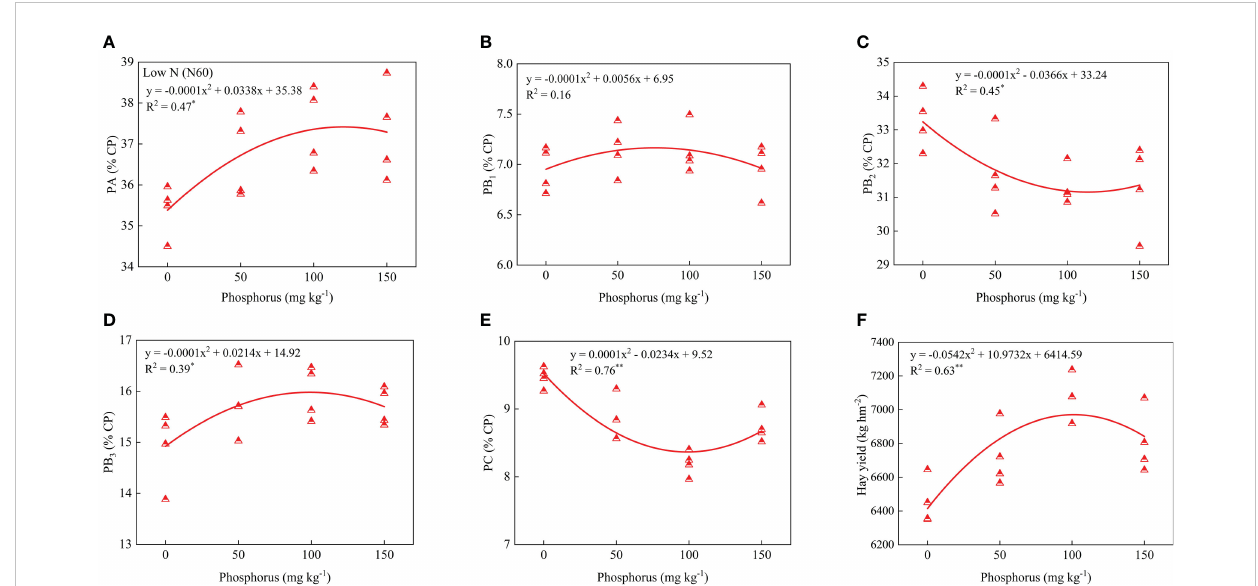
FIGURE 5 Relationship of PA (A) , PB 1 (B) , PB 2 (C) , PB 3 (D) , PC (E) , and forage yield (F) with phosphorus treatments under low nitrogen condition. * and ** indicates the signi fi cant level at p ≤ 0.05 and p ≤ 0.01, respectively. The X and Y axes were adjusted to minimize the graph ’ s blank areas and highlight the relationship.